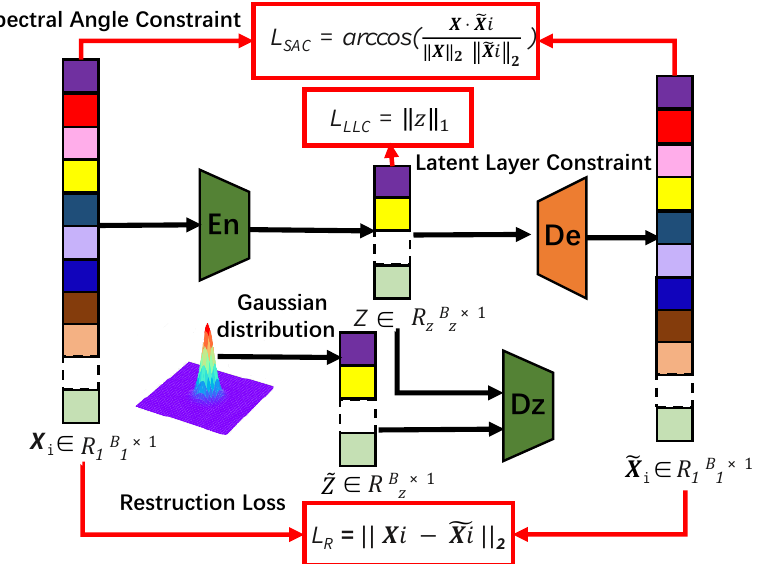
Figure 3. The detailed information of spatial branch network